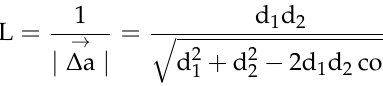
Figure 5. ( a ) TEM image of composite sintered at 900 °C; ( b ) SAED pattern of copper matrix in ( a ); ( c ) BF image showing the nanosized V particles below 10 nm; ( d ) HRTEM image of the interface between V and Cu and ( e ) the EDS result of the V particle in ( c ). 3.2. Properties of Samples Figure 6a,b shows the variation of microhardness, yield strength, and compressive strength of samples with the sintering temperature. It can be seen that increasing the sintering temperature could lead to the reduction of microhardness and the strength level. However, the sample sintered at 950